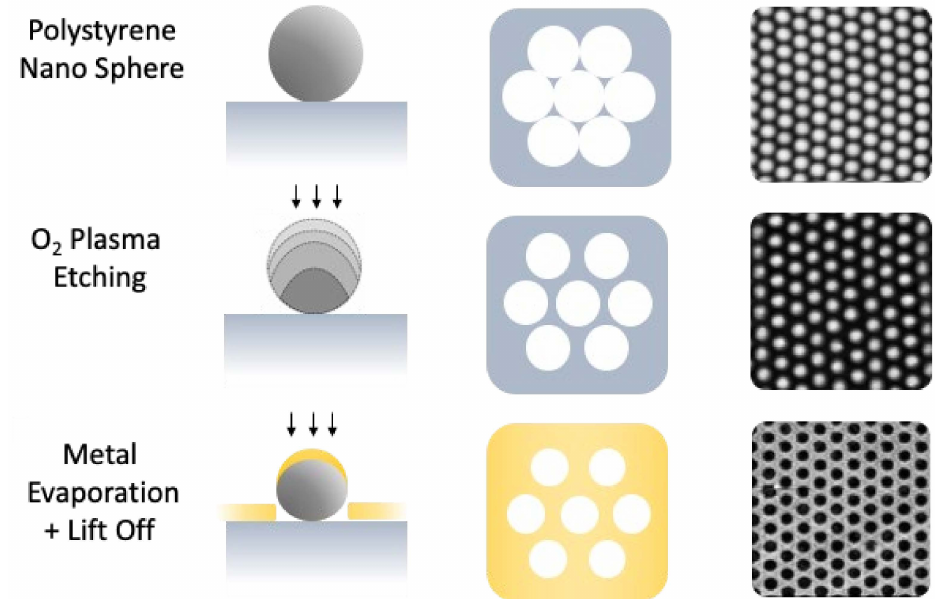
Figure 1. Schematic representation of the nano-hole array fabrication process: after obtaining the CPA of NPs, the size of the NPs are reduced by an oxygen plasma treatment. The NCPA thus obtained is used as a mask through which the metal is evaporated to obtain the ordered nano-holes